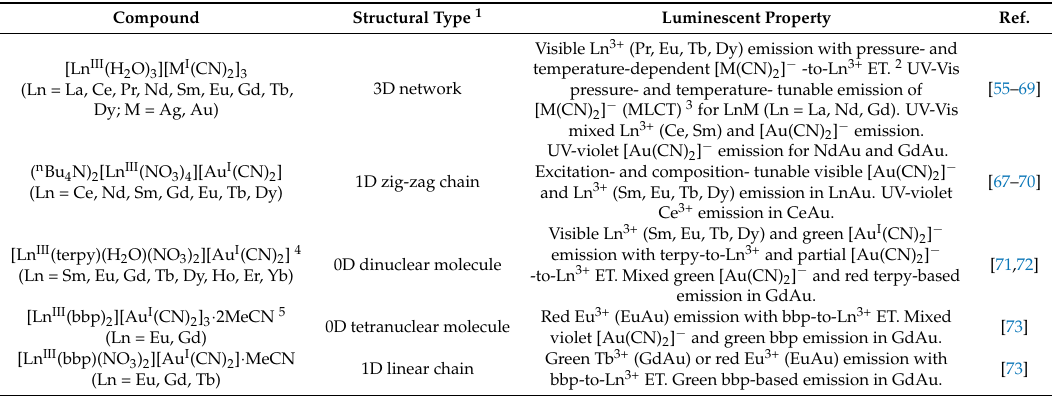
Table 1. Photoluminescent dicyanidometallate-based compounds containing lanthanide ions. Compound